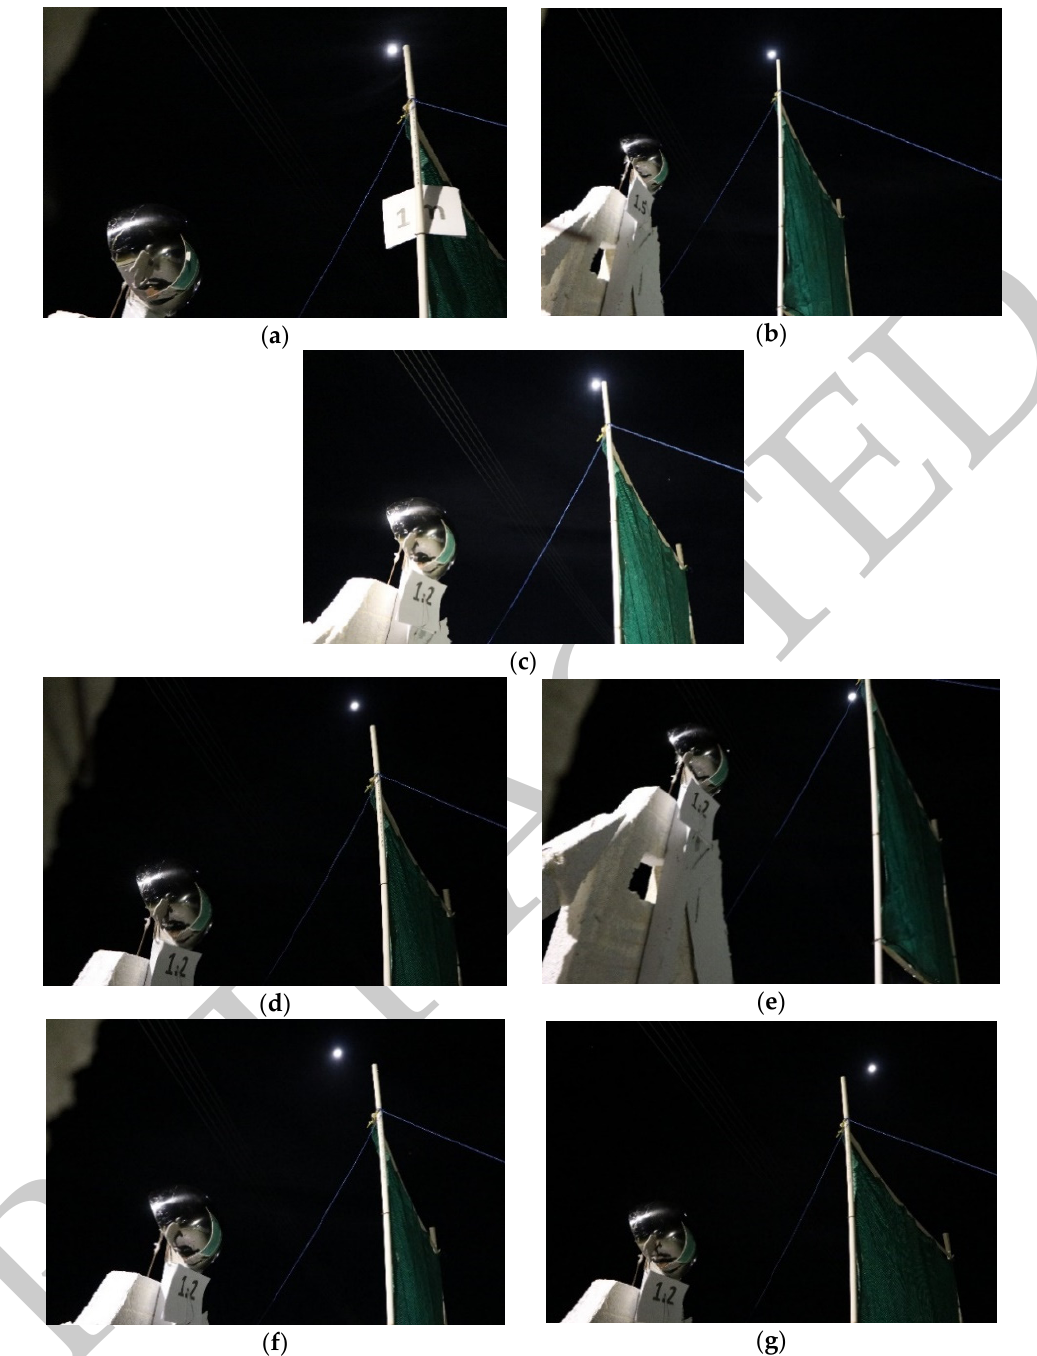
Figure 15. Reproduction photos taken from different heights from ground level and distances from the flag end (indicated on labels in each figure); ( a ) camera 1.0 m high from ground level and at 1.7 m distance from the flag end; ( b ) camera 1.2 m high from ground level and at 1.5 m distance from the flag end; ( c ) camera 1.5m high from ground level and at 1.2 m distance from the flag end; this is the most probable position of the Apollo 17 astronaut-photographer in a standing position with the camera fixed to his chest; ( d – g ) camera at 1.2 m distance from the flag end with relative movement up, down, left, and right.